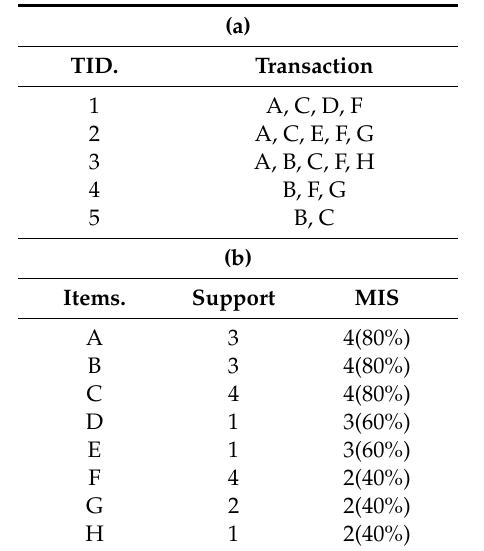
Table 9. Transaction database, actual support, and MIS of each item for Experiment